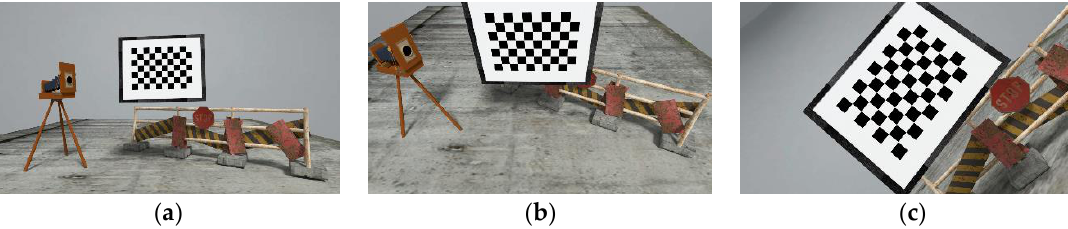
Figure 4. Example of rendered images for simulated datasets from the datasets 4 through 6; ( a ) excerpt from dataset 4; ( b ) excerpt from dataset 5; ( c ) excerpt from dataset 6.